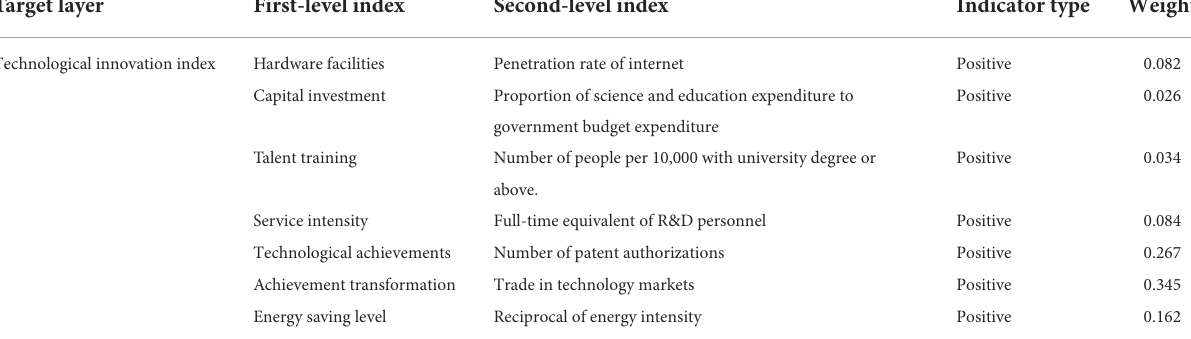
TABLE 2 The index system of technological